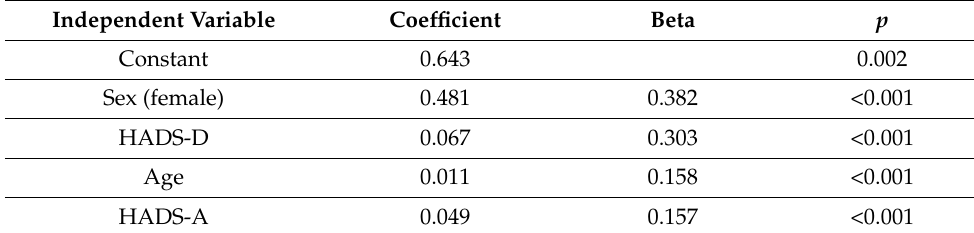
Table 2. Linear regression (MI baseline = dependent